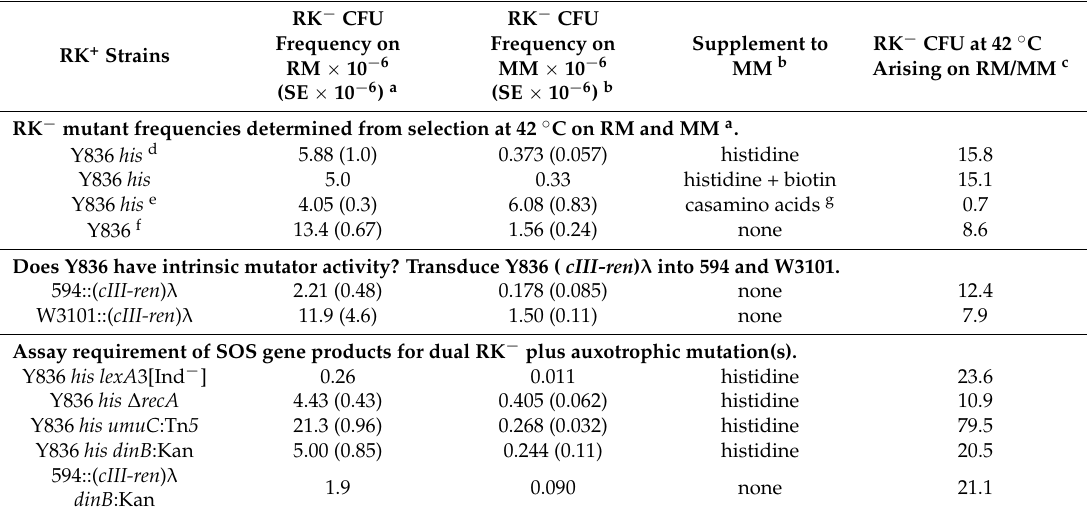
Table 1. RK ´ mutation frequencies.